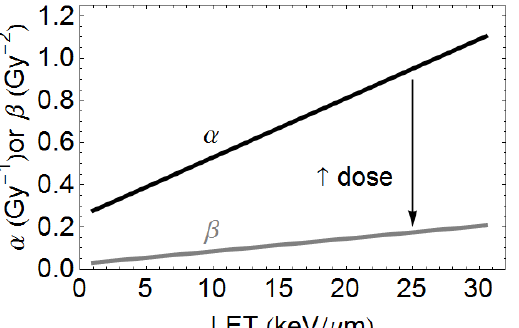
Figure 10. Schematic diagram of change in α and β with LET to show general principles for a hypothetical case. Increasing dose will increase the proportion of β mediated cell kill and so cause a lower overall RBE, as determined by both the increment in α (which changes RBE max ) and in β (which change RBE min ), and so the relative proportions of RBEmax and RBEmin which contribute to the overall RBE. The increase in β with LET is always smaller than that in α . In this way, with increasing dose, the overall RBE follows the direction of the arrow. The numbers used in this figure are arbitrary and not intended to represent any particular cell system.